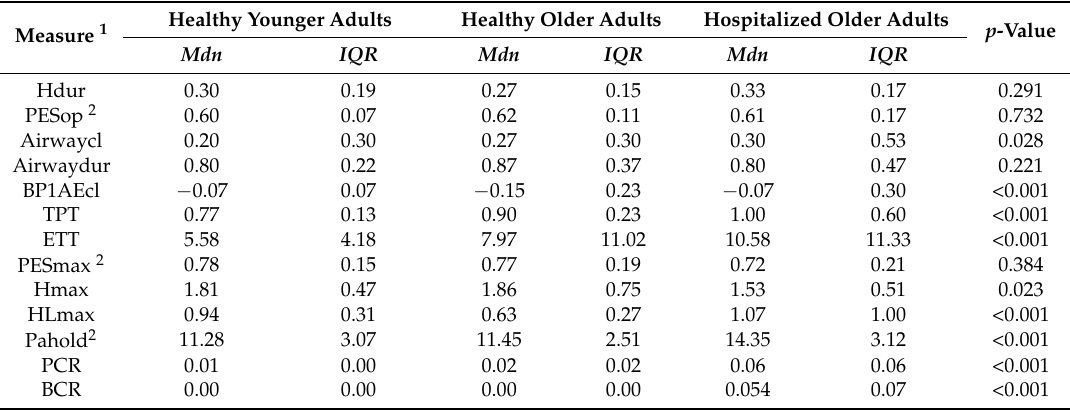
1 refer to Table 1 for definitions of measures. 2 M and SD .